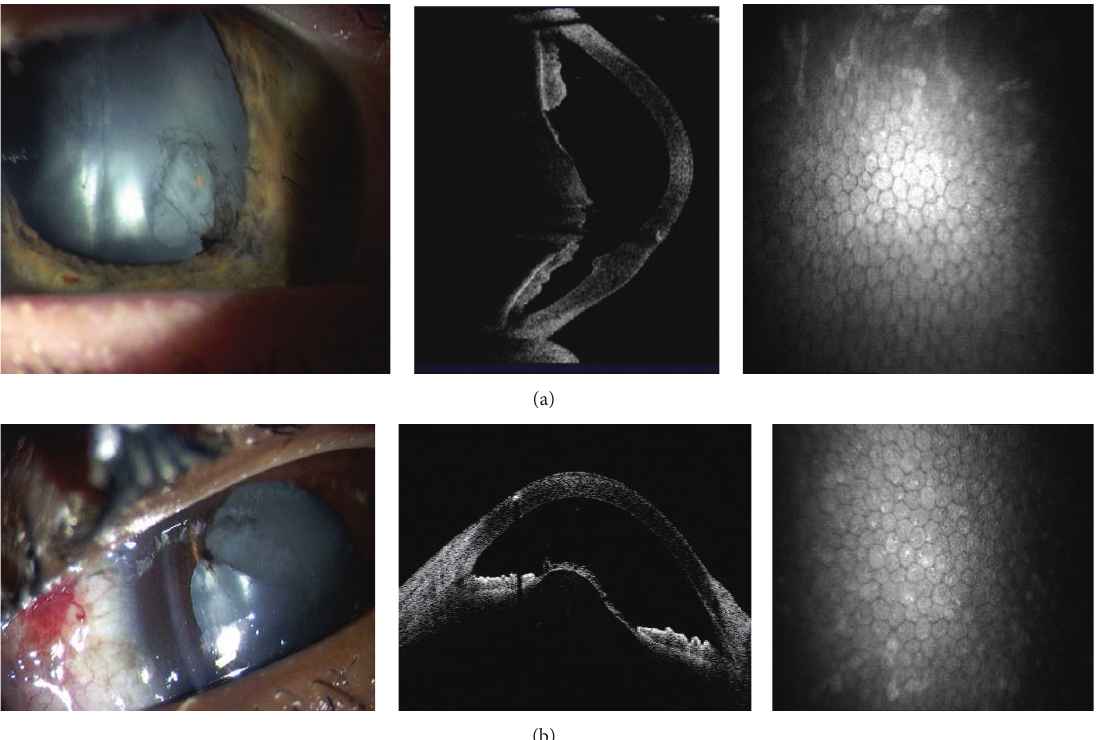
Figure11:(a)Traumaticcataractwithdisruptionofanteriorlenscapsuleandcornealscar.(b)Intraocularforeignbodyandresultingtraumatic cataract.